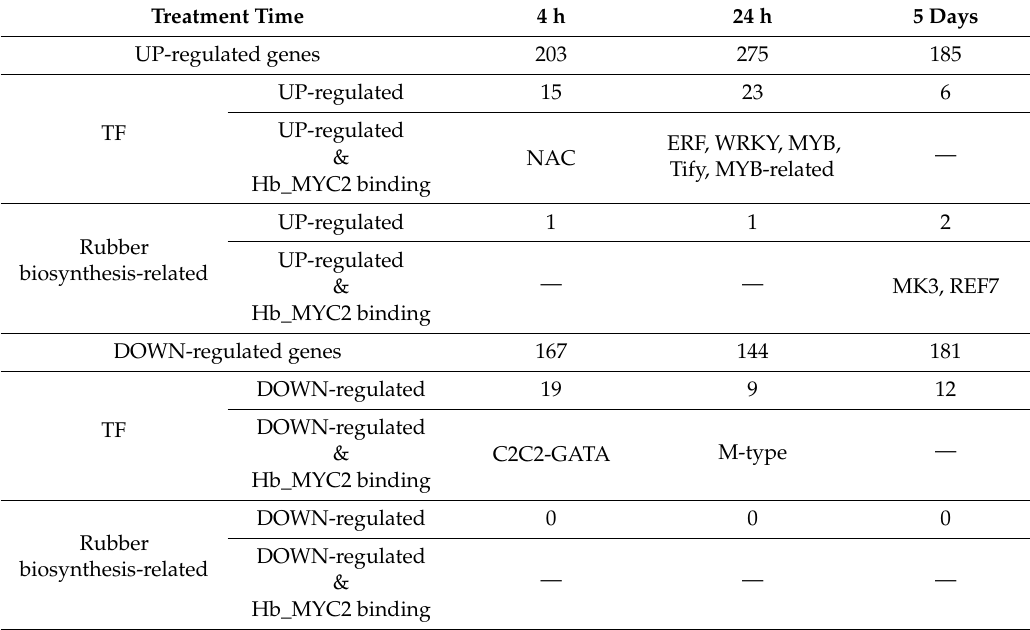
Figure 1. Time-course RNA-seq analysis of suspension-cultured cells upon MeJA treatment for 4 hours (h), 24 h, and 5 days (d). ( A ) Procedure of time-course RNA-seq analysis. Di ff erentially expressed genes (DEGs) were identified by comparison between MeJA and DMSO (control) treatments at each time point ( p -value < 0.05 and fold di ff erence > 1.5 or < 2 / 3). ( B ) Venn diagrams of the overlaps between up- or downregulated genes at 4 h, 24 h, and 5 days after MeJA treatment. ( C ) Heatmap of mRNA accumulation of nine rubber biosynthetic genes. The latex data were obtained from previous tissue-specific RNA-seq analysis [11]. NT = Non-treatment, D = DMSO, M = MeJA. Table 1. Summary of time-course RNA-seq analysis.